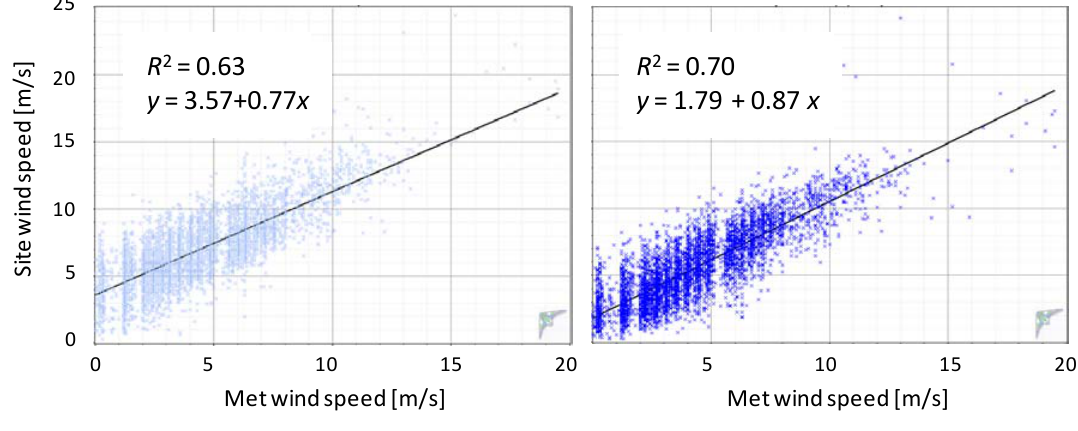
Figure 15. Regression plots for hourly wind speed values. (a) Correlation of 60 m site data with 10 m met data. (b) Correlation between the downscaled (10 m) site data and the 10 m met